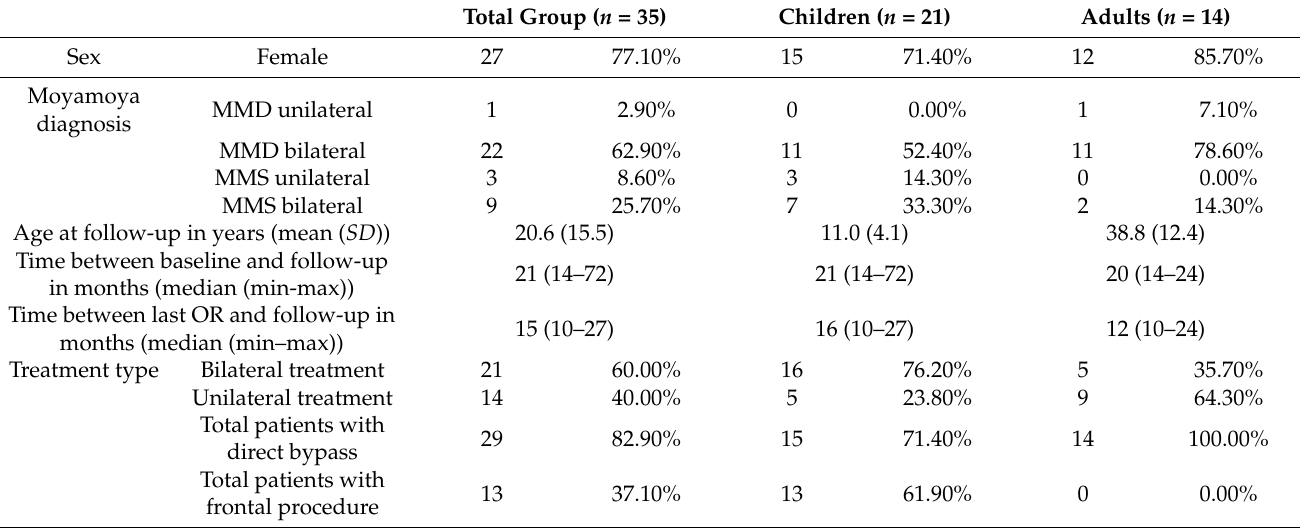
Table 1. Patient characteristics and